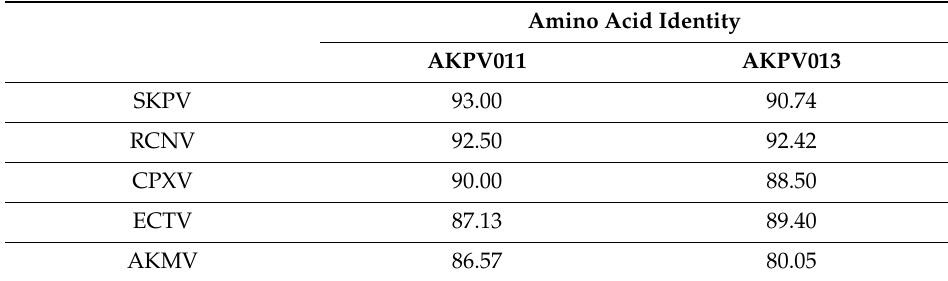
Table 2. Percent amino acid identity of TNF α receptor-like AKPV011 and ankyrin repeat-containing AKPV013 with corresponding proteins from representative OPXV genomes, including SKPV,